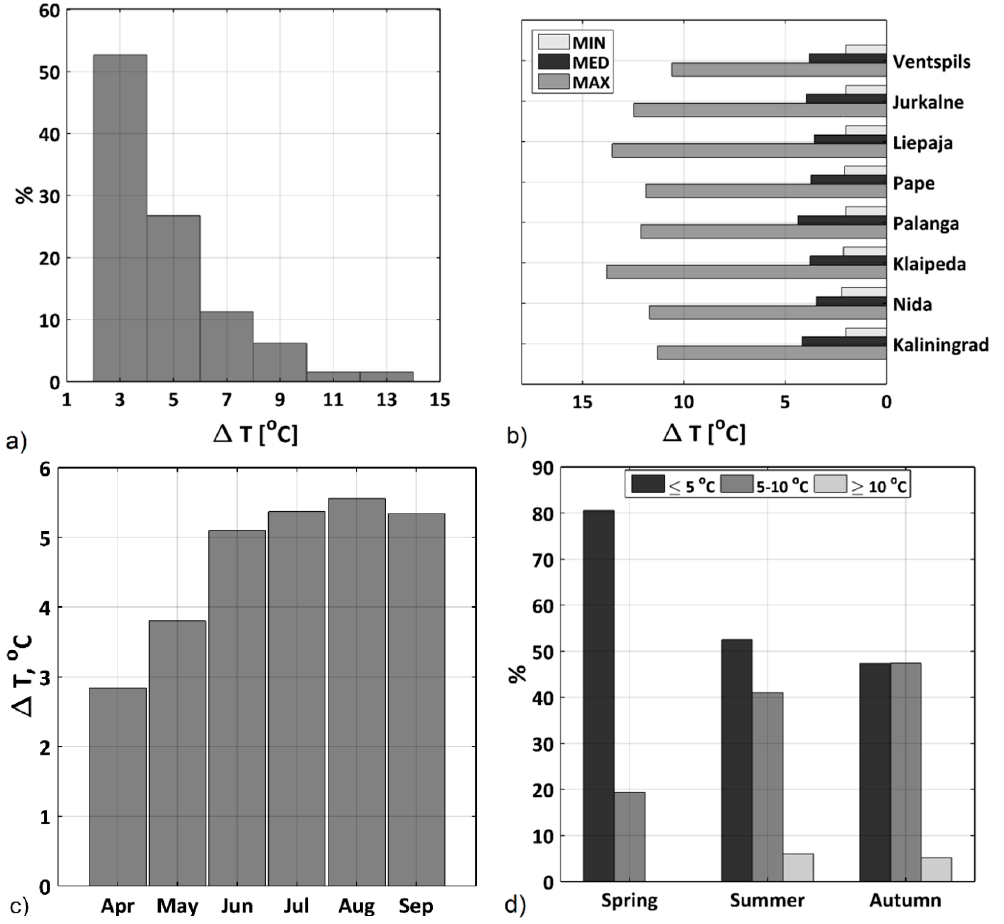
Figure 7. Upwelling induced SST modulations for the period 2000–2015: ( a ) upwelling induced SST drop ( ∆ T); ( b ) spatial distribution of ∆ T along the SE Baltic (SEB) coast; ( c ) mean monthly ∆ T; ( d ) seasonal changes of ∆ T.